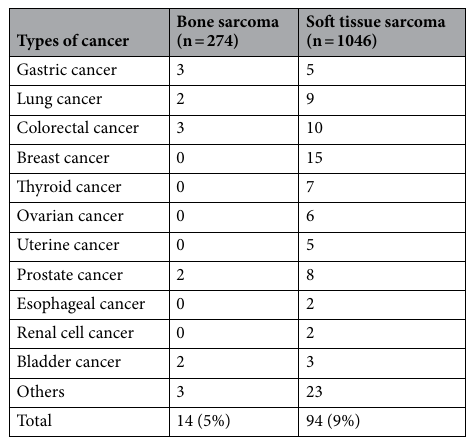
Table 2. Other types of cancer in sarcoma patients.